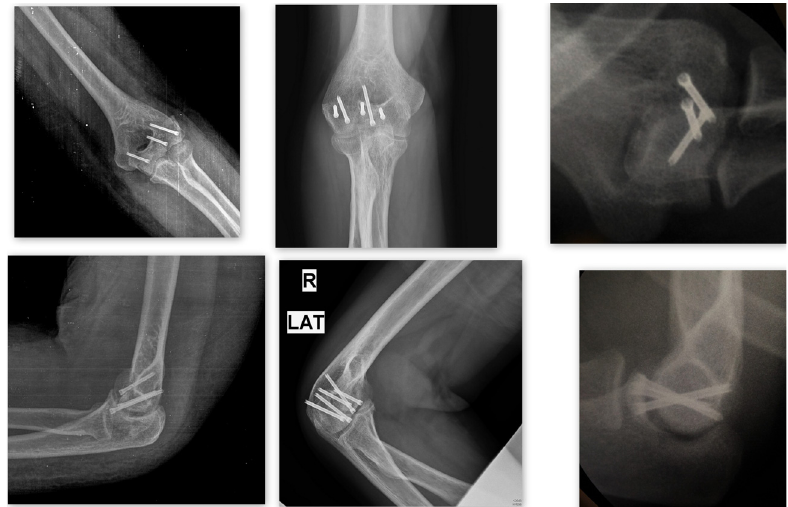
Figure 8. Post op X-rays showing union of